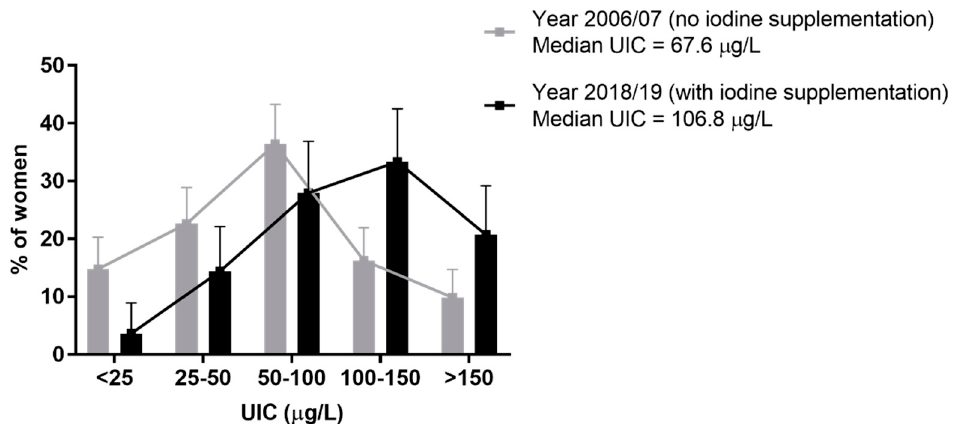
Figure 1. Distribution of urinary iodine concentration (UIC) in untreated ( n = 203) and iodine-supplemented ( n = 111) pregnant women, studied in 2006/07 and 2018/19, respectively. Supplementation with a daily dose of 200 µ g iodine resulted in a shift towards a higher UIC in pregnancy (chi-square test p < 0.0001). For clarity, UIC higher than 150 µ g/L have been grouped together. Bars represent percentages (%) of total and error bars represent 95% confidence intervals. Table 2. Urinary iodine concentration (UIC) according to gestational period.